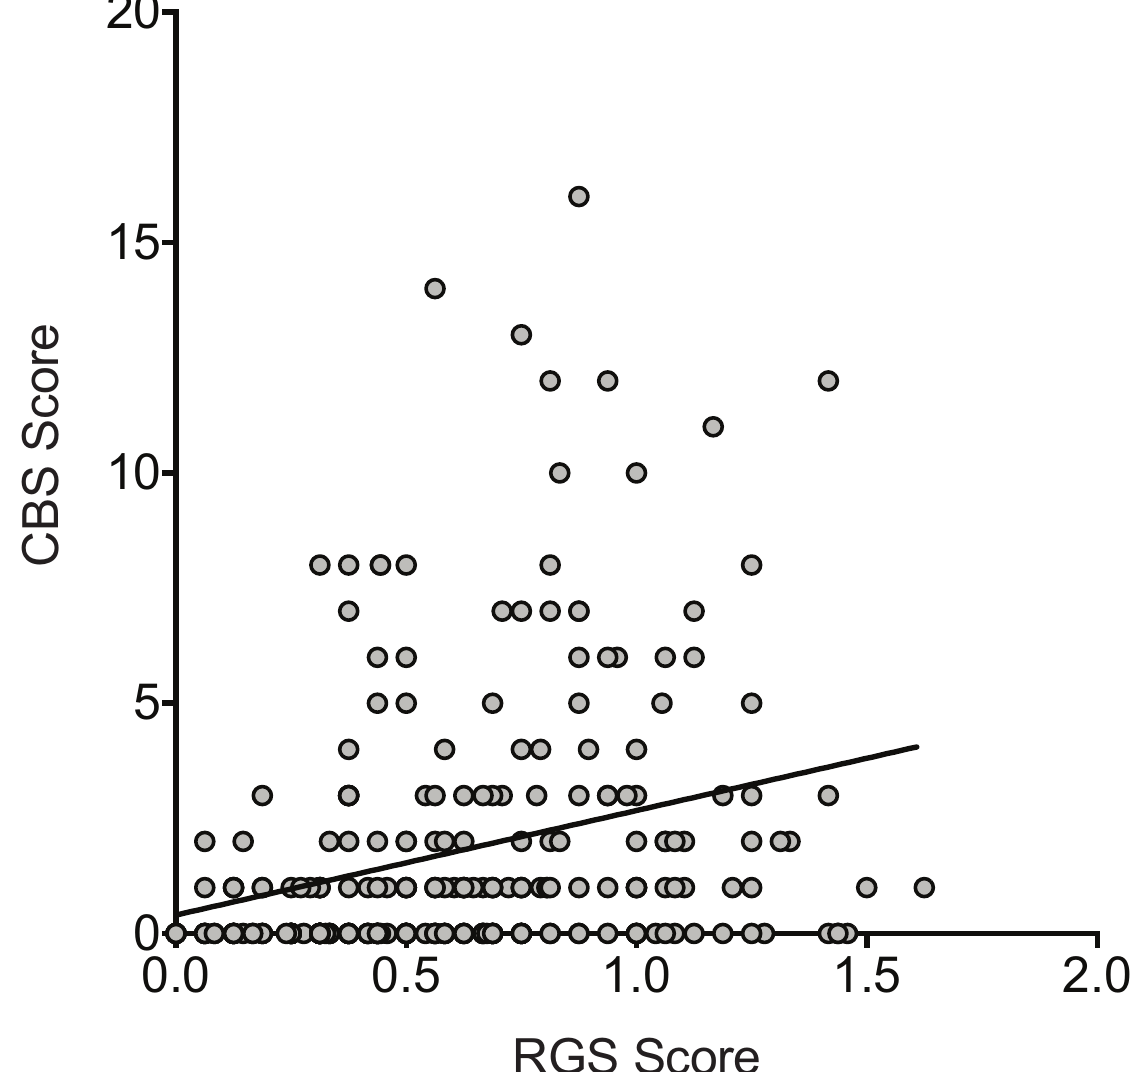
Fig 5. RGS and CBS scores are positively correlated. Data from all groups and all timepoints are plotted (260 xy pairs) with each point representing an individual rat. r = 0.36 (95% CI, 0.25 to 0.47), p < 0.0001.